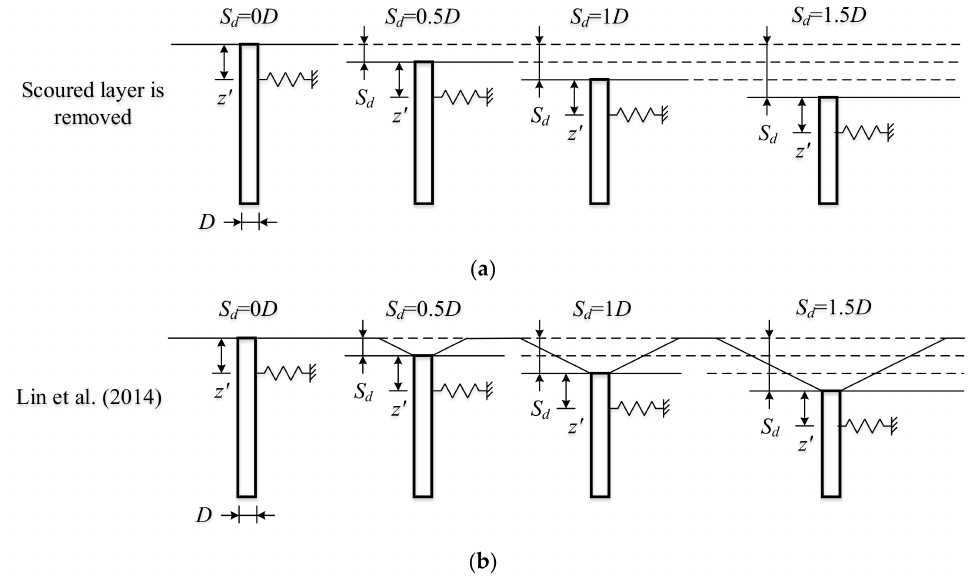
Figure 10. Boundary conditions of different methods considering the effect of scour. ( a ) Consider the soil below the bottom of scour hole; ( b ) Consider the geometry of scour hole.